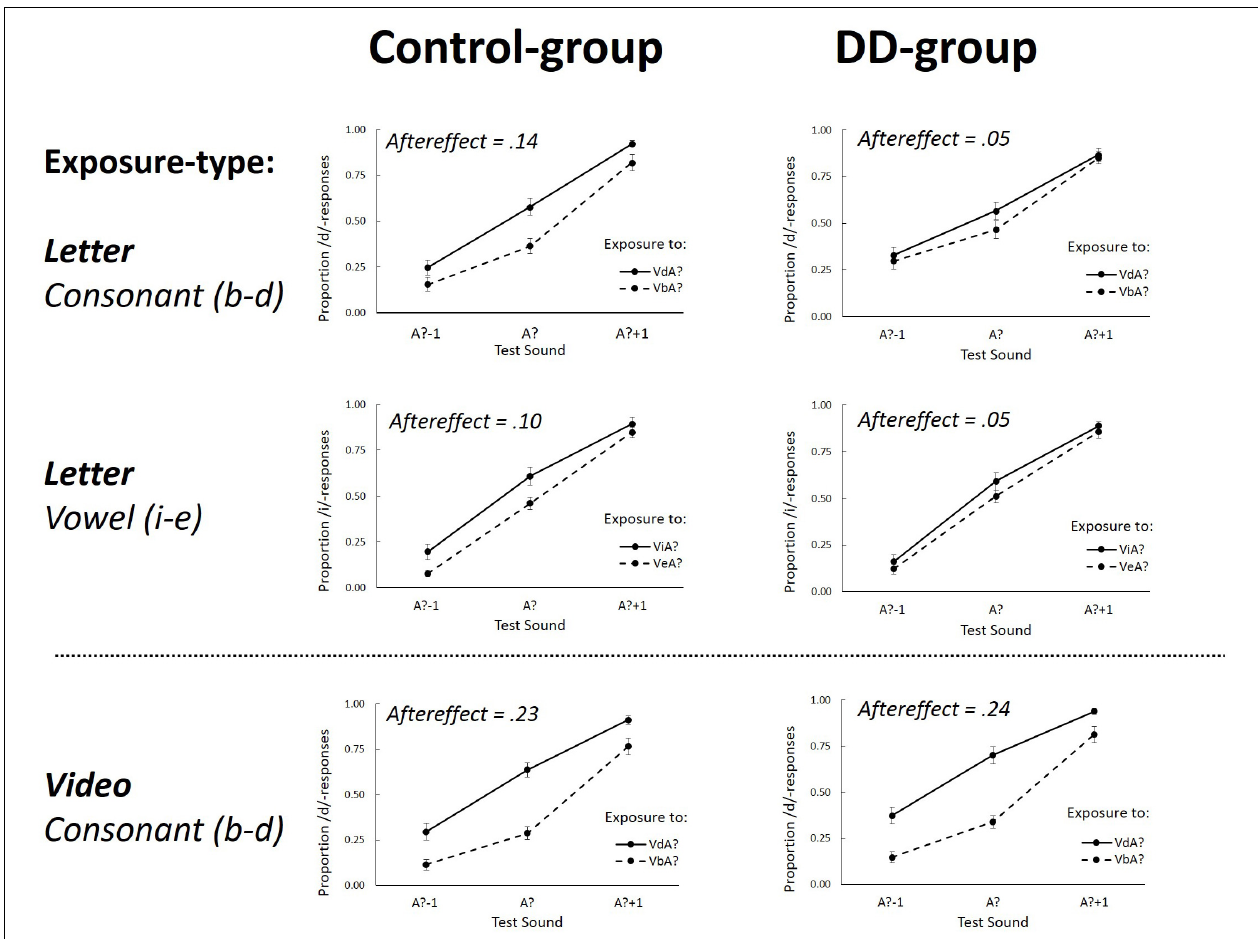
FIGURE 2 | The proportion of /d/ (Experiment 1, Consonant) or /i/-responses (Experiment 2, Vowel) as a function of the three different Test-sounds (A?–1; A? and A?+1) after ambiguous Exposure-sounds. Graphs separately depict Letter (upper four graphs) and Video (lower two graphs) Exposure-types for the Control group (left graphs) and DD group (right graphs). Aftereffects represents the overall difference between the two Exposure-tokens (VdA? – VbA? for consonants, and ViA?–VeA? for vowels). Error bars represent the standard errors of the mean.